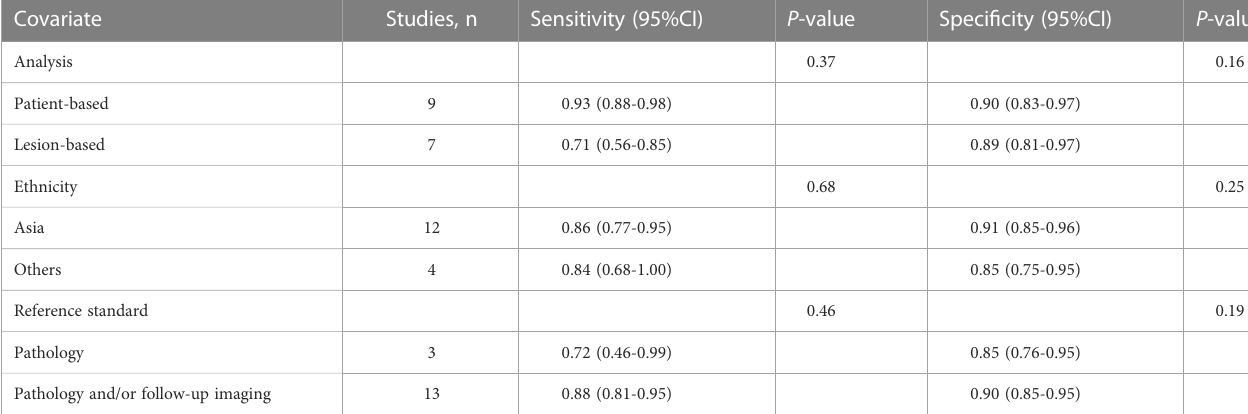
TABLE 5 Meta-regression analysis of 18F-FDG PET/CT for colorectal liver metastasis.